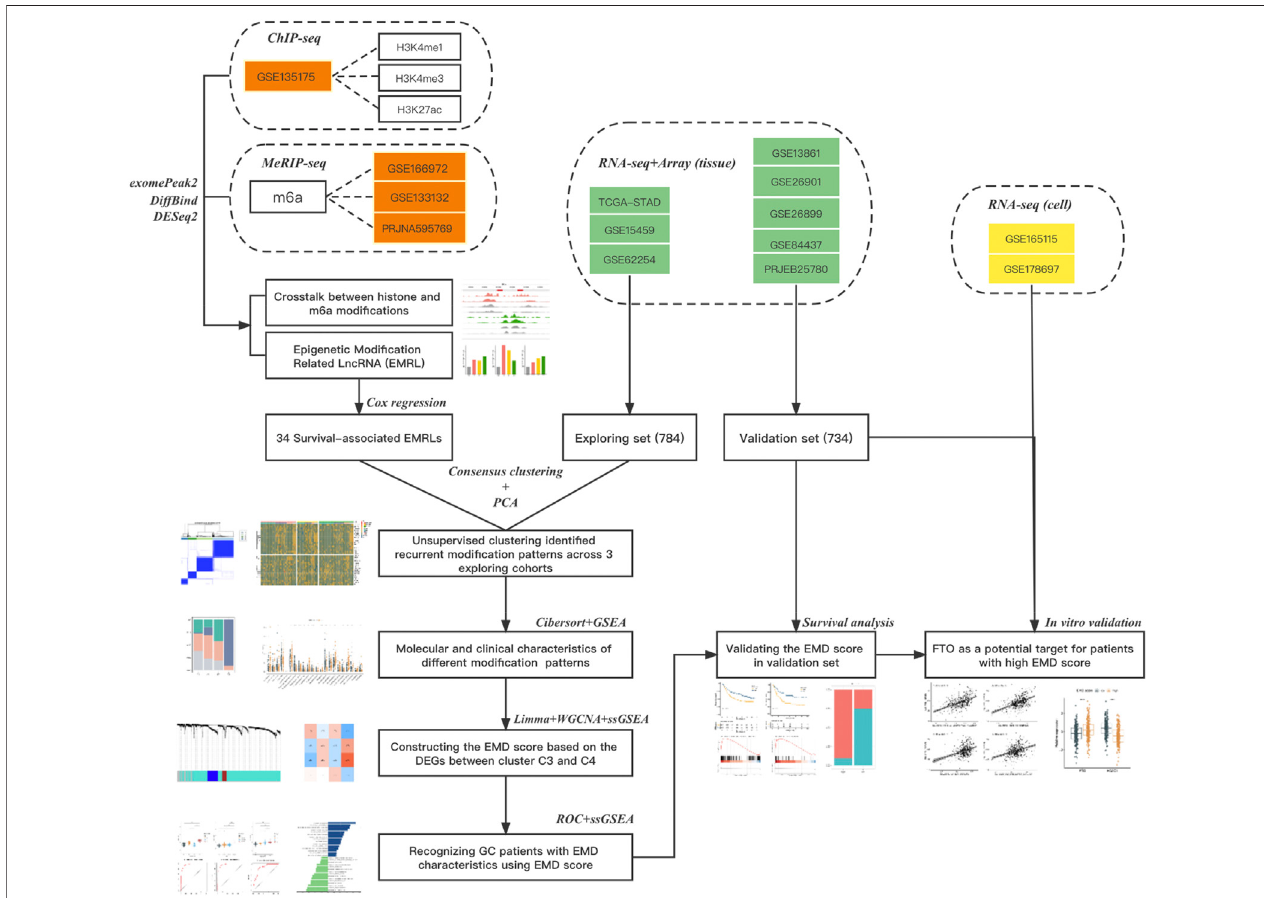
FIGURE 1 | Flow chart of this study. Three types of data from 14 datasets were used in this study: datasets in red refer to the epigenetic data (ChIPseq or MeRIPseq) targeting on histone or m6A modi fi cations, datasets in green refer to the RNAseq or array data with complete clinical information (survival or ICI response), and datasets in yellow refer to the RNAseq data of cell lines with or without FTO depletion. The main method used in each step was also listed.